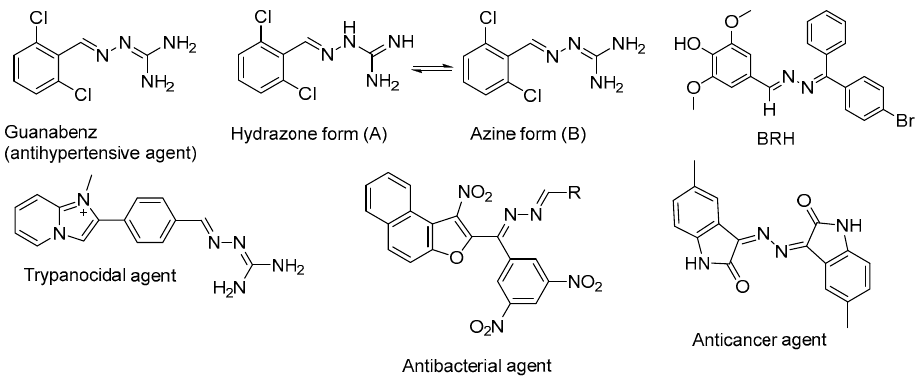
Figure 1. Examples of biologically active azines.